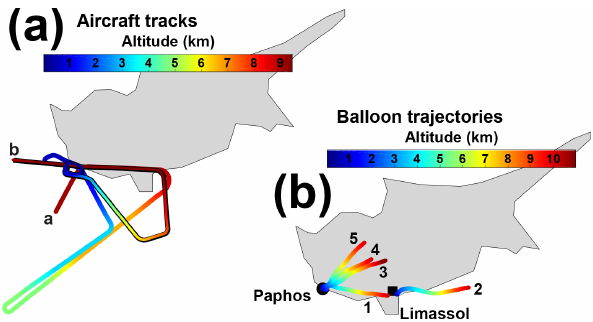
Figure 3. Flight tracks of (a) the DLR Falcon aircraft and (b) the UCASS sondes launched from Paphos and Limassol. The Falcon tracks marked a (black border) and b (no border) refer to the re- search flights on 20 and 21 April 2017, respectively.